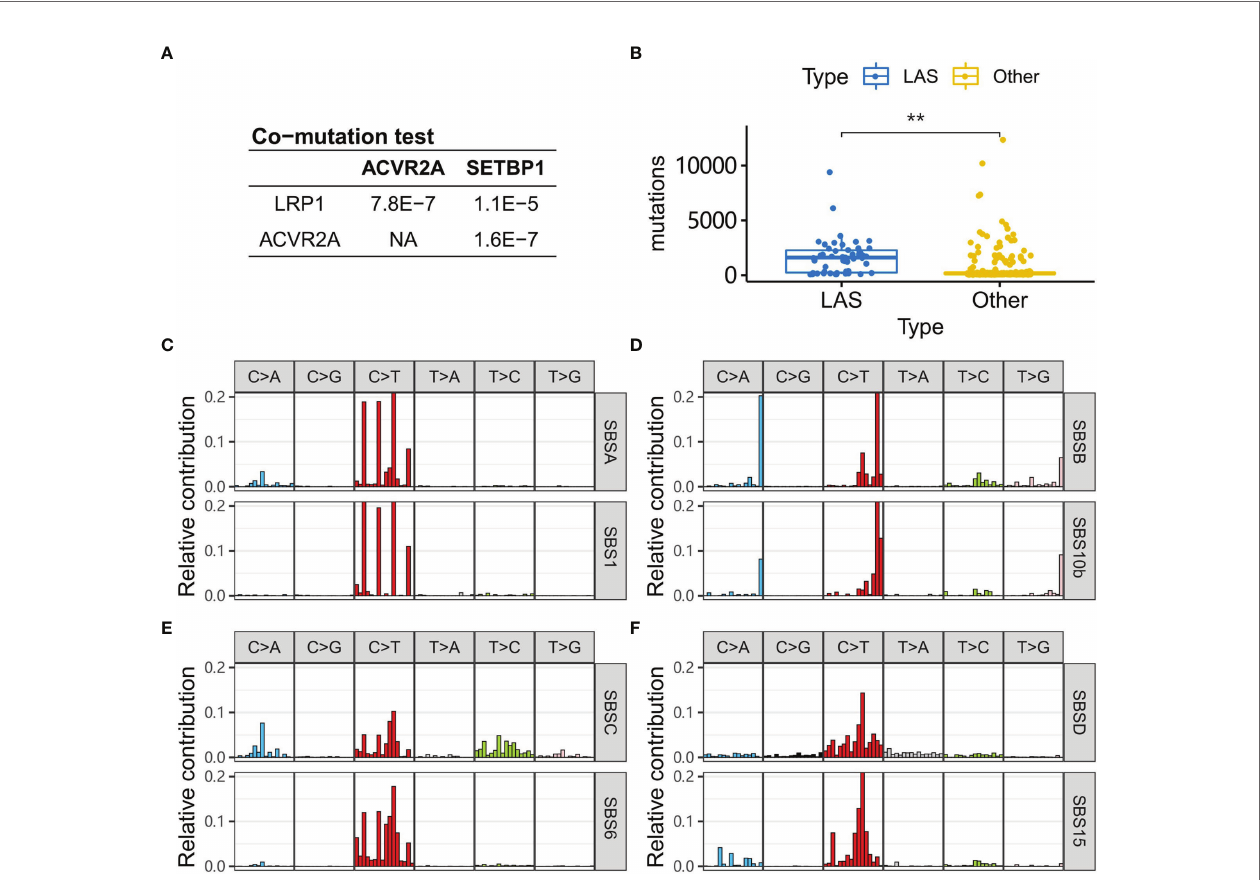
FIGURE 6 | LAS type patients in the COAD cohort. (A) P -values of the co-mutation between each pair of LRP1 , ACVR2A , and SETBP1 are calculated with Fisher ’ s exact test. (B) Tumors of LAS subtype patients have more mutations than the other patients. (C – F) Four signatures (SBSA, SBSB, SBSC, SBSD) are extracted from the COAD cohort. They are respectively similar to the signatures, SBS1, SBS10b, SBS6, and SBS15, in the COSMIC database. “ ** ” denote P -value <